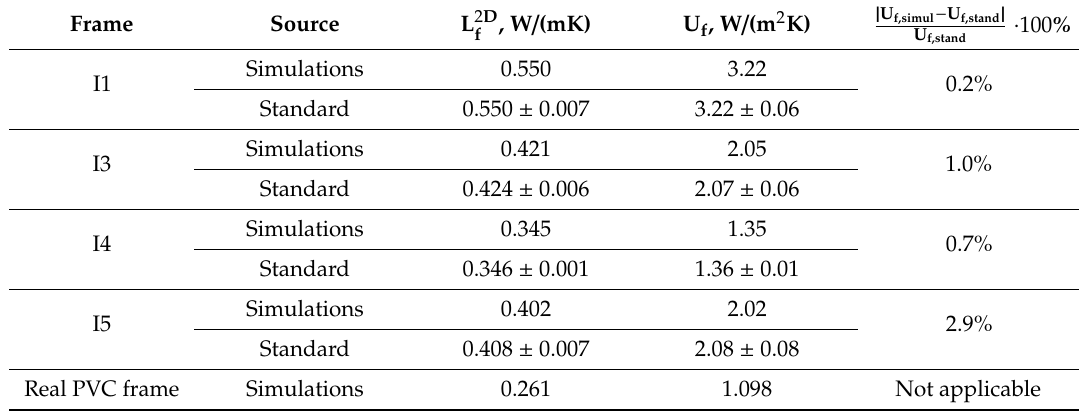
Table 2. Comparison of the simulation results and the results from the standard ISO